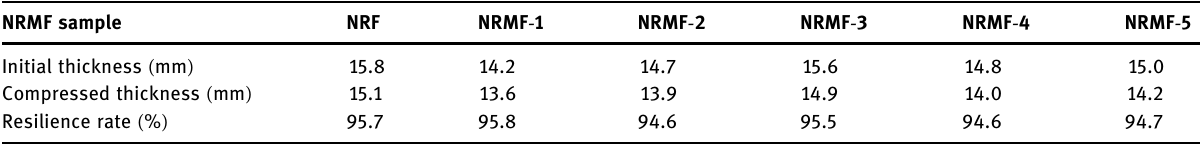
Table 1: Resilience rate of NRMF NRMF